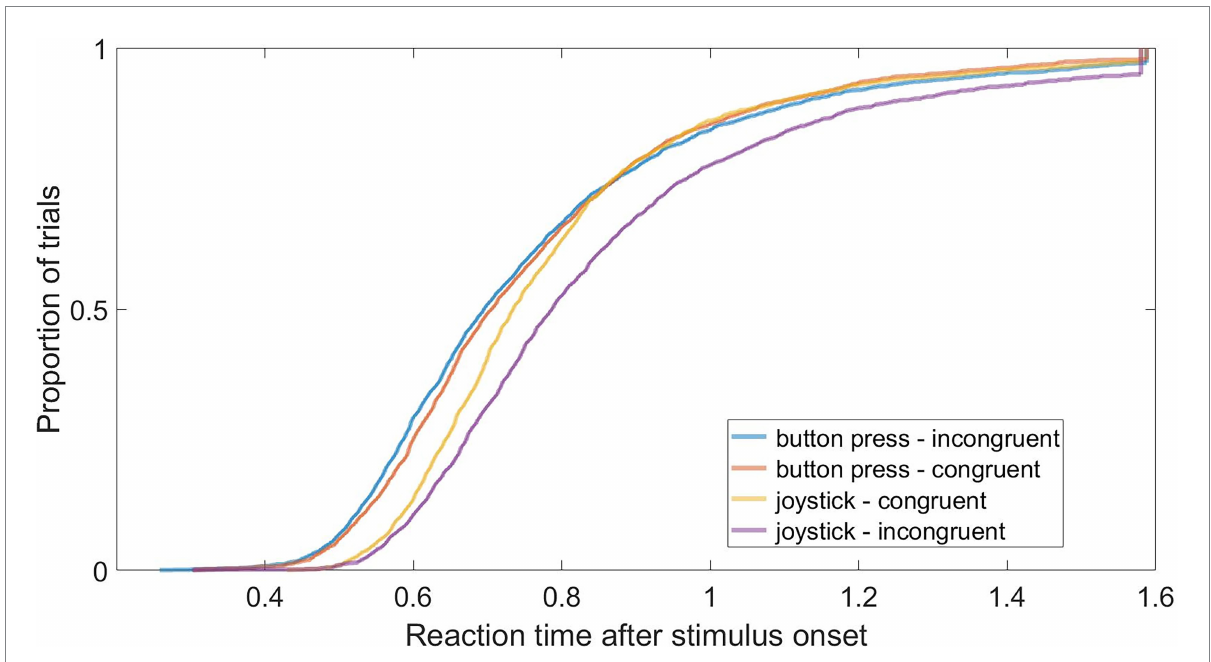
FIGURE 3 Cumulative Distribution Function of all condition-pairs between joystick/response pad and